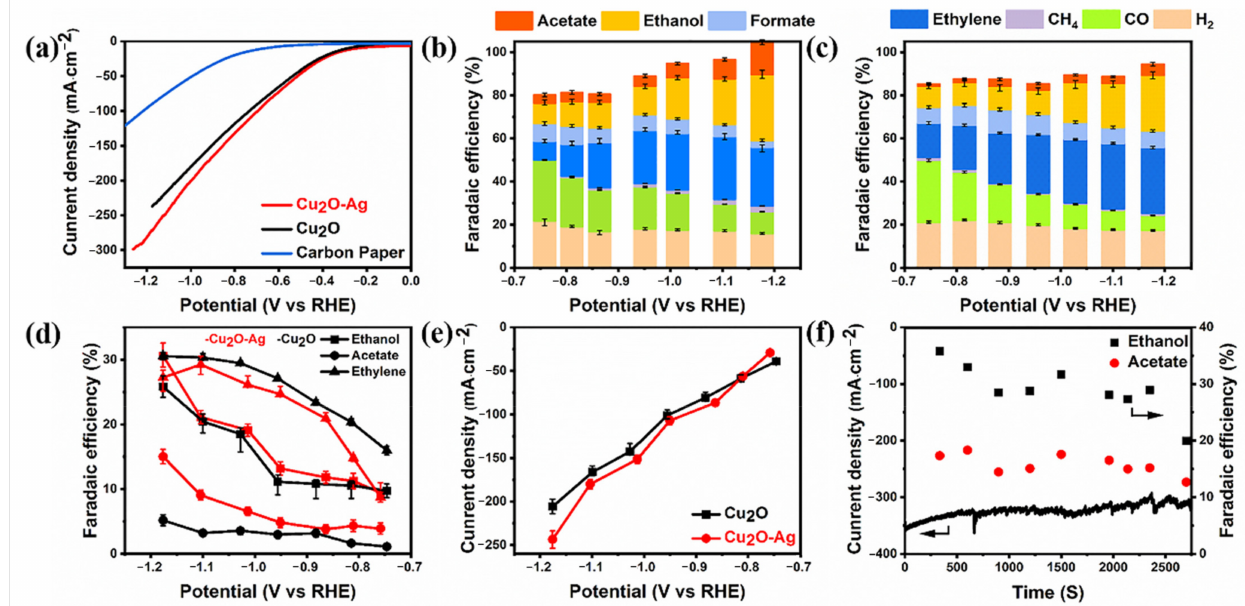
Figure 3. ( a ) LSV curves on the Cu 2 O-Ag and Cu 2 O nanocubes in 1 M KOH electrolytes. Blue curves obtained from the blank GDL in 1 M KOH electrolytes. ( b ) Faradaic efficiencies of all CO 2 RR products on the Cu 2 O-Ag nanocubes. ( c ) Faradaic efficiencies of all CO 2 RR products on the Cu 2 O nanocubes. ( d ) Faradaic efficiencies of ethylene, acetate and ethanol of Cu 2 O-Ag and Cu 2 O nanocubes at different applied potentials. ( e ) Partial current densities of C 2 products of Cu 2 O-Ag and Cu 2 O nanocubes at different applied potentials. ( f ) Stability test in 1M KOH electrolytes at − 1.18 V versus